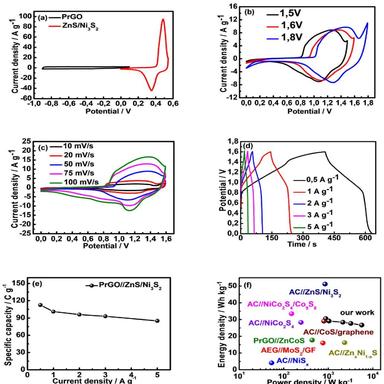
(a) CV curves of the positive and negative electrodes at a scan rate of 10 mV s1 ; (b) CV curves recorded at different cell voltages; (c) CV curves at different scan rates; (d) GCD curves recorded as a function of current density; (e) the corresponding specific capacity as a function of current density; (f) typical Ragone plot of the hybrid supercapacitor.